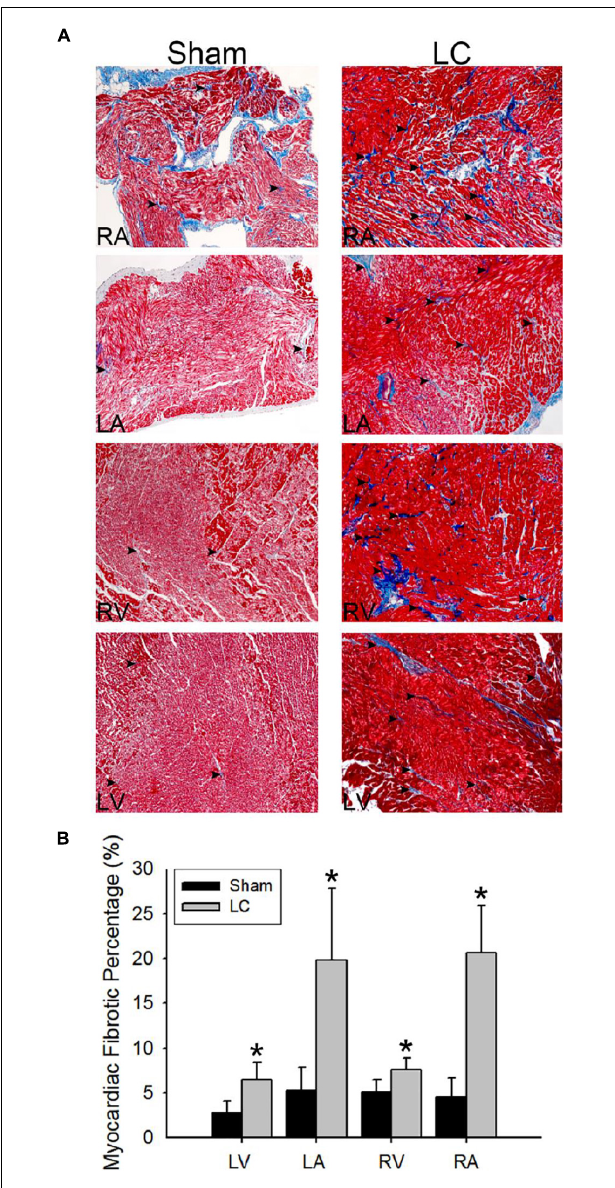
FIGURE 3 | Masson’s trichrome stain for fibrosis quantification of the myocardium. (A) The Masson’s trichrome stain (magnification 200 × ) of the atrial and ventricular myocardium in the sham and LC groups. The red color indicates the normal myocardium. The blue color indicates the fibrotic tissue (denoted in black arrowheads). (B) The comparison of percentages of myocardial fibrotic area from Masson’s trichrome stain between the groups. * p < 0.01 compared with the LC